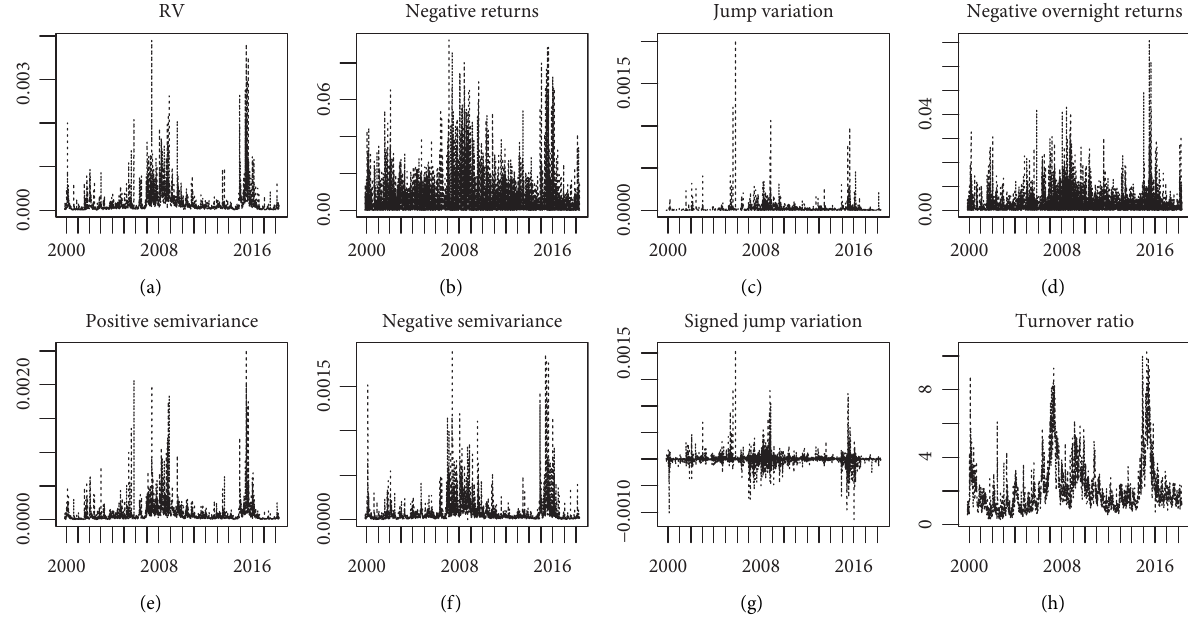
Figure 1: Time series plot of variables. (a) Panel A, (b) Panel B, (c) Panel C, (d) Panel D, (e) Panel E, (f) Panel F, (g) Panel G, and (h) Panel